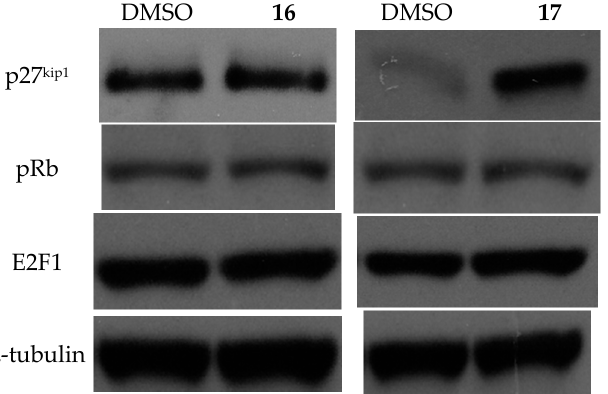
Figure 8. Immunoblot analysis of p27 kip1 and E2F1 proteins isolated from SH-SY5Y cells treated with